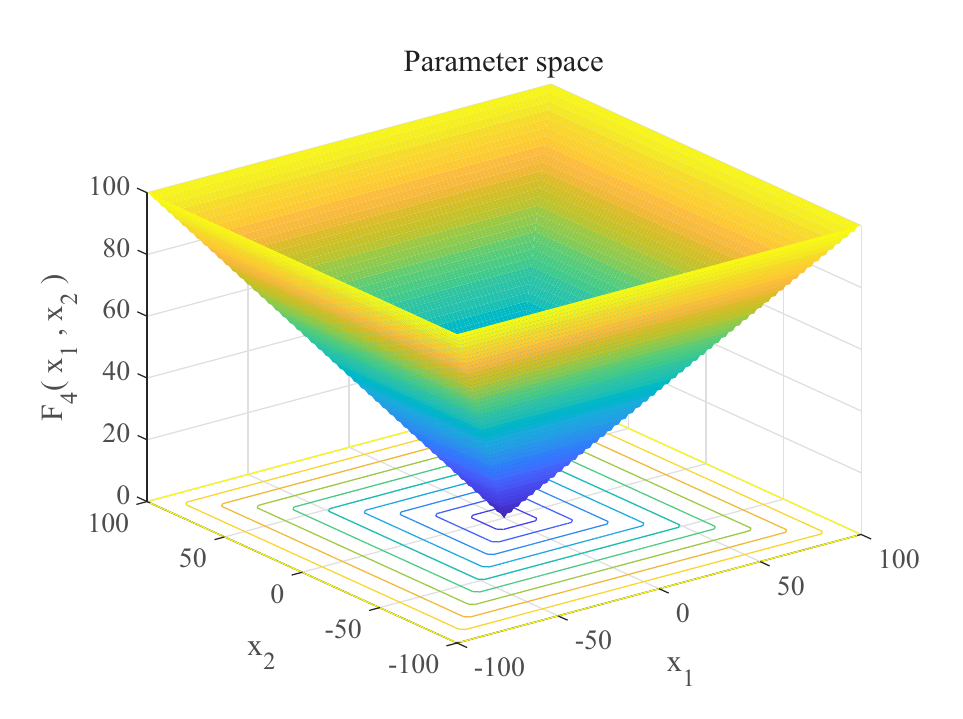
Fig 5. Three-dimensional graph of F 4 ( x ).